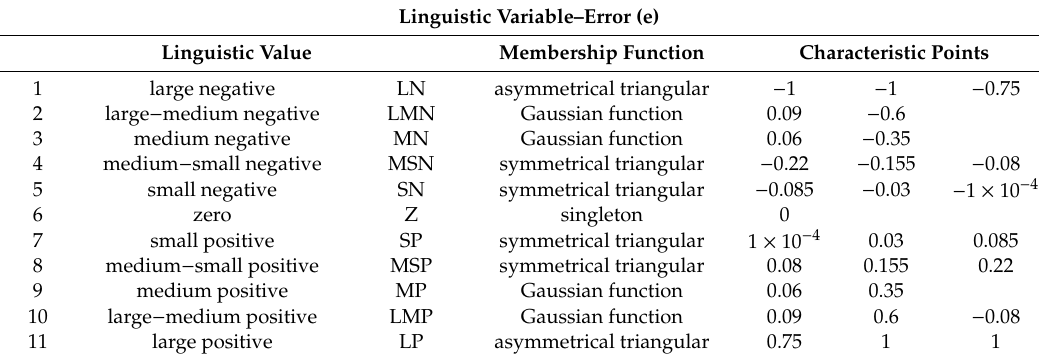
Table 7. The second version of the controller–error.